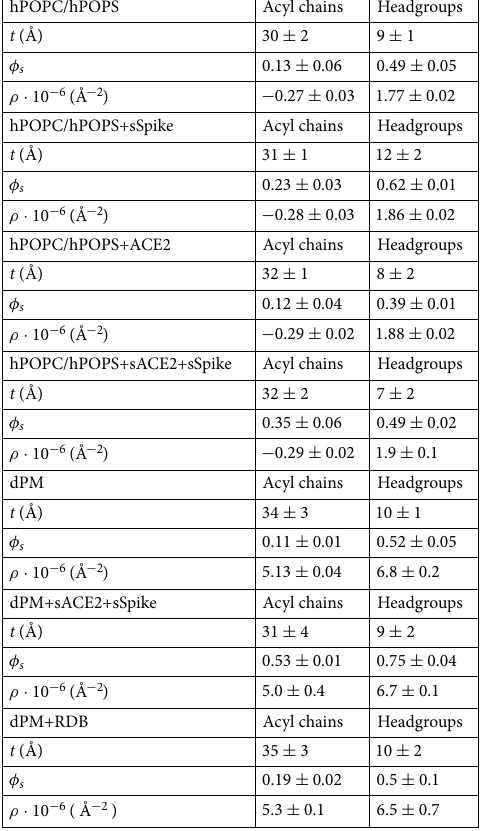
Table 1. Optimised parameters from NR data analysis: thickness ( t ), solvent volume fraction ( φ s ), scattering length density ( ρ ). Surface roughness was in the range of 3–4 Å for all the investigated